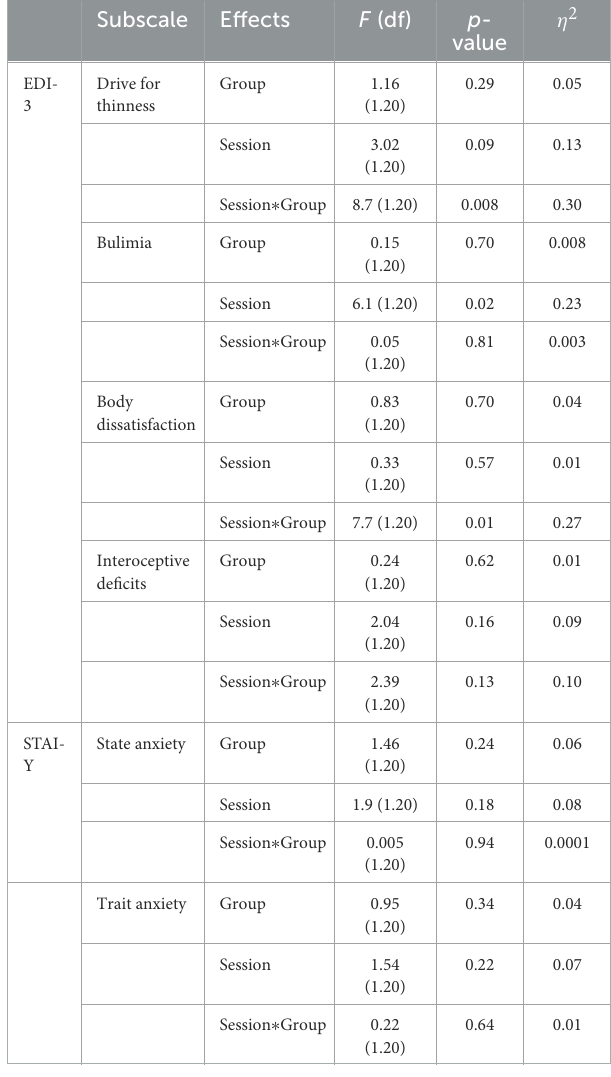
TABLE 3 Univariate